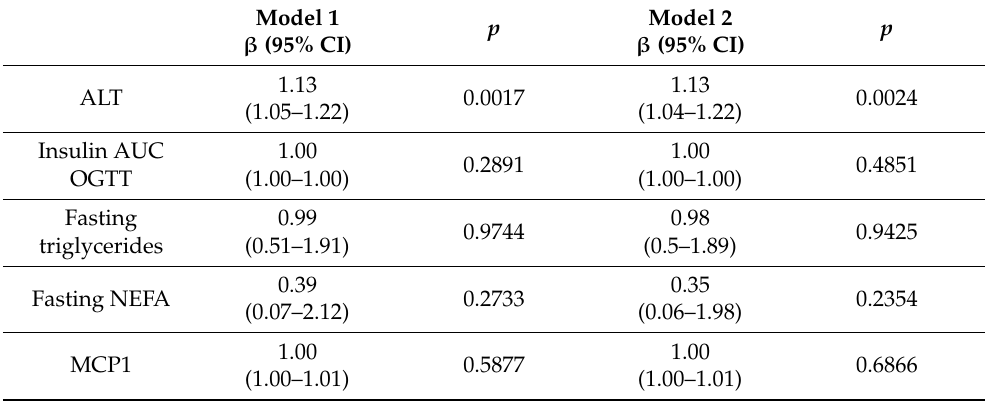
Table 5. Contribution of obesity-related biomarkers (odds ratio and 95% confidence interval (CI)) to the risk of elevated (>150 U/L) cytokeratin plasma